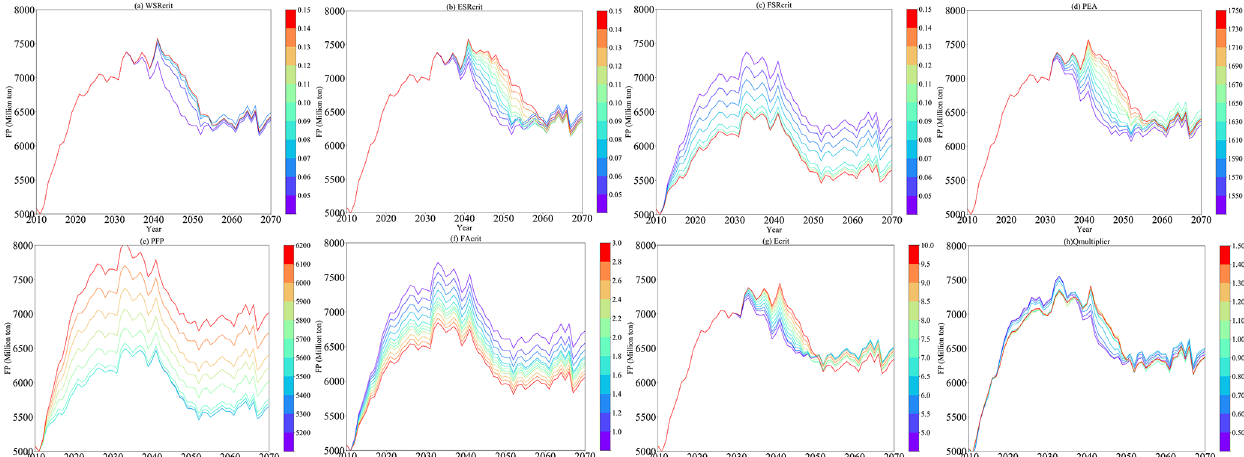
Figure 11. Trajectories of food production with varied